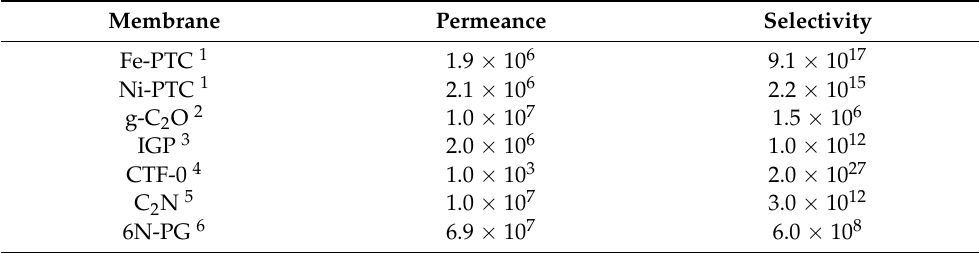
Table 4. Comparison results of He permeance (GPU) and the He/N 2 selectivity between Fe/Ni-PTC MOF and previously proposed porous membranes at 300 K. (1 GPU = 3.3 × 10 − 10 mol s − 1 m − 2 Pa − 1